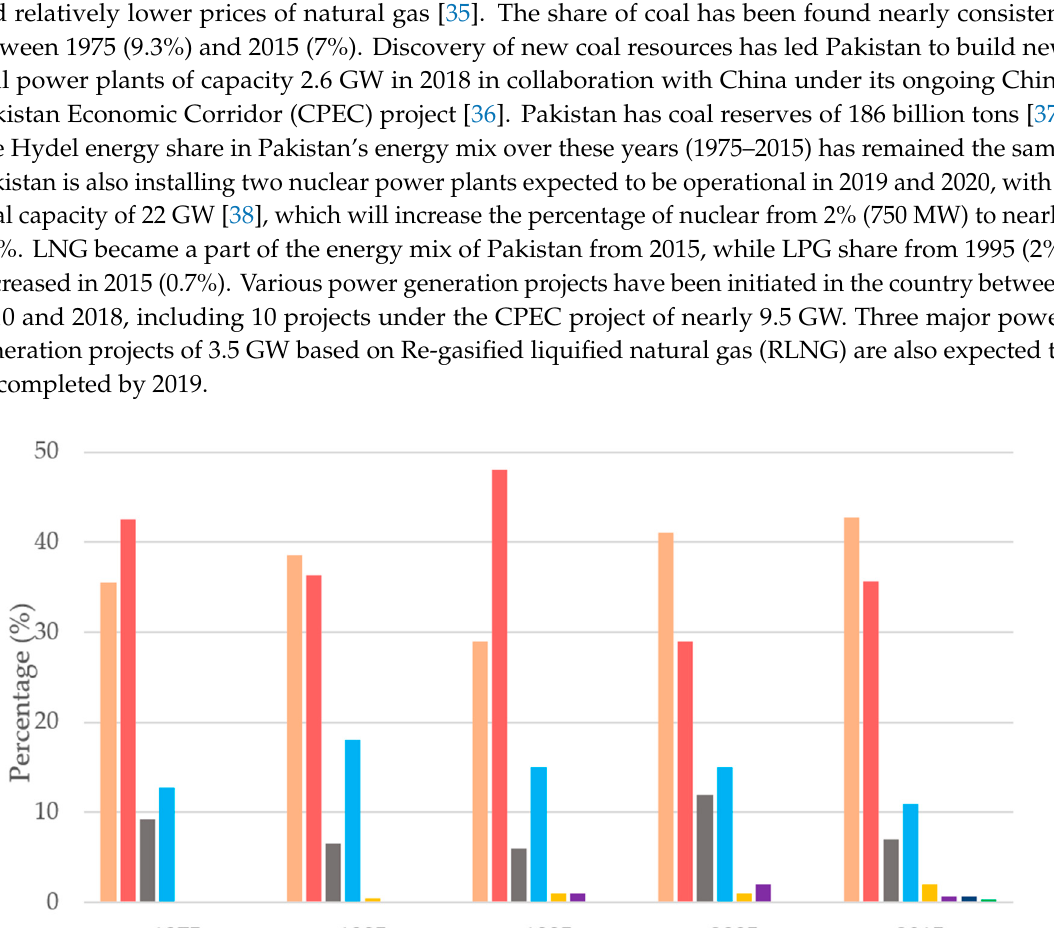
Figure 8. Provincial share of electricity generation and consumption of Pakistan [40,41].